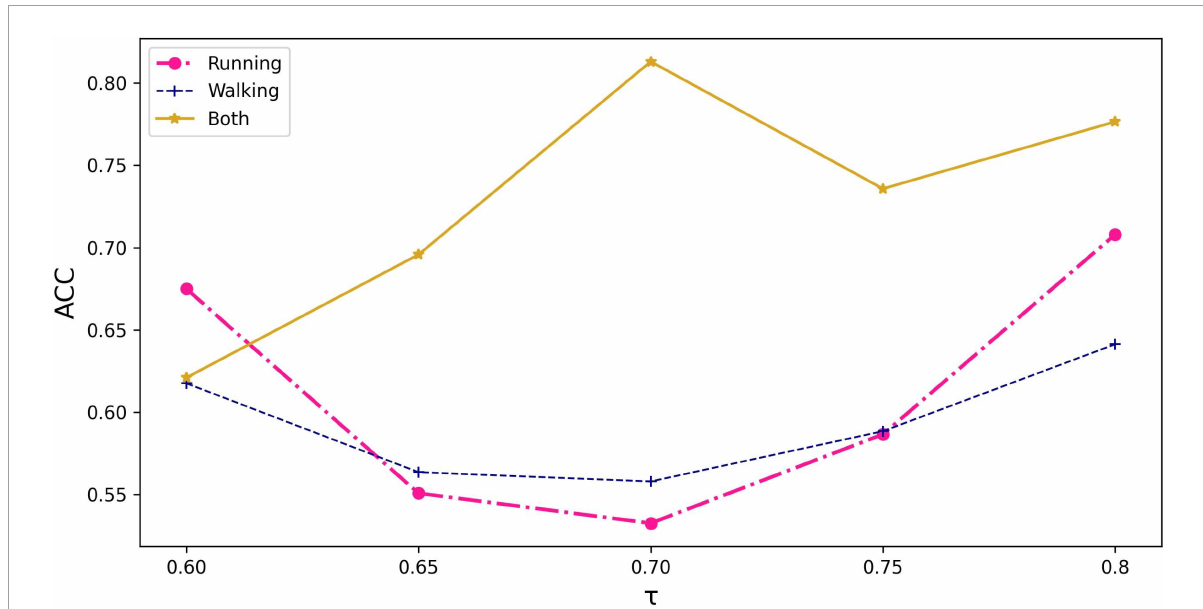
FIGURE3 The impact of input information and threshold selection on classification performance expressed as accuracy. τ represents the threshold value being set in equation (3).